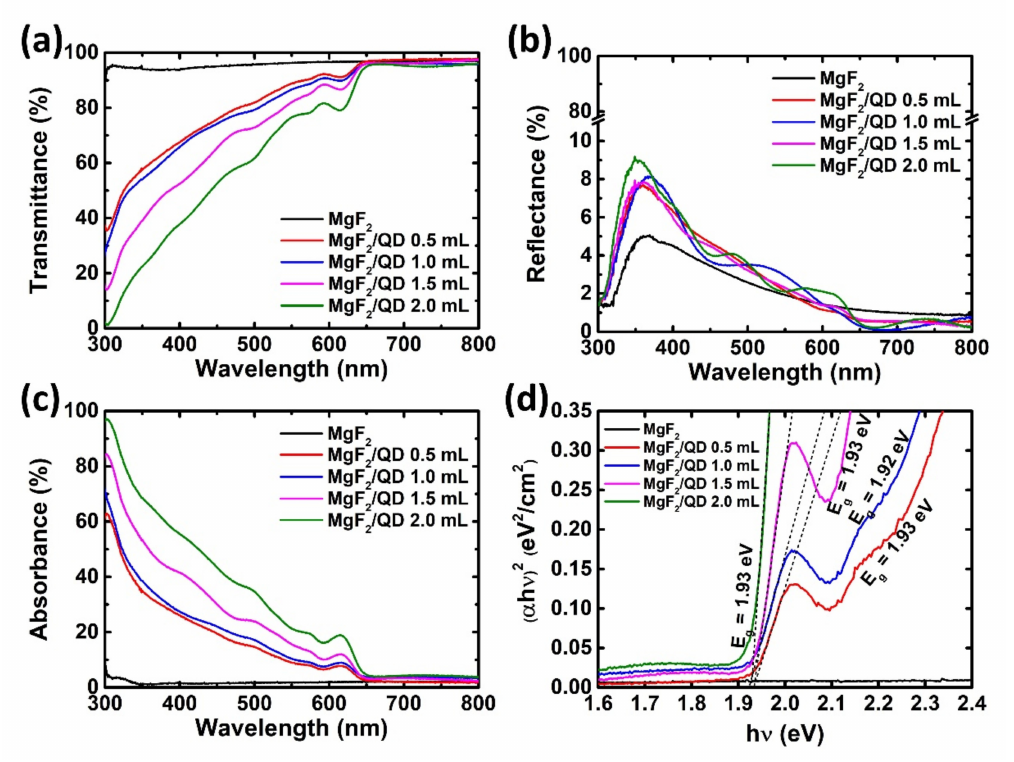
Figure 3. ( a ) Transmittance, ( b ) reflectance, and ( c ) absorbance spectra of the MgF 2 and MgF 2 /QD layers on glass for different wavelengths of the incident light; ( d ) Tauc plots and bandgap energies ( E g ) of the MgF 2 /QD layers obtained from the absorbance spectra.